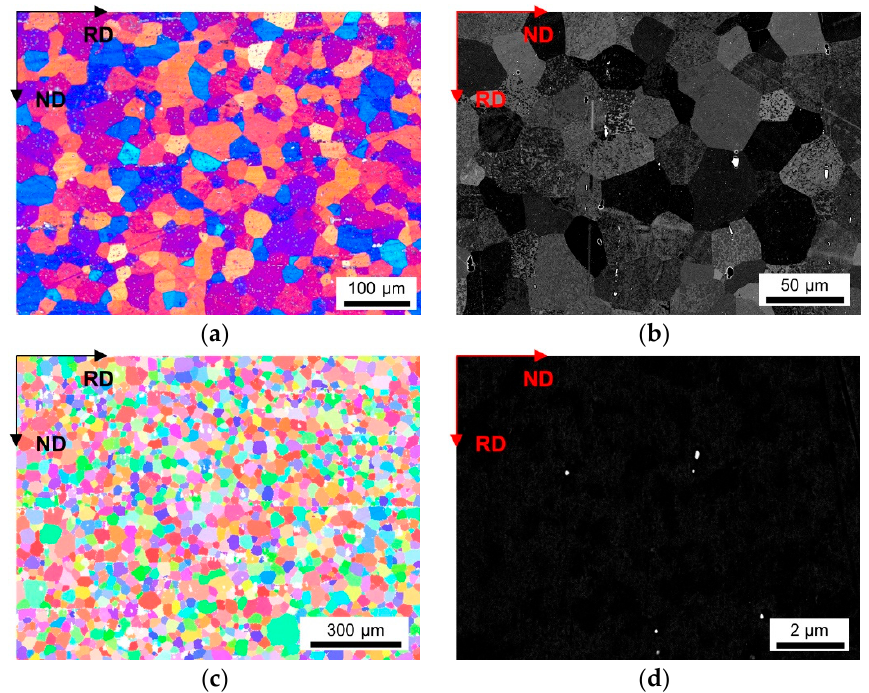
Figure A5. Microstructure of the soft annealed LFe-LMn cast under S-C condition, homogenized at 550 °C and cold rolled to a CRD of 63%. ( a ) LOM. ( b ) BSE image. ( c ) EBSD IPF map in RD–ND plane. ( d ) BSE micrograph showing dispersoids.